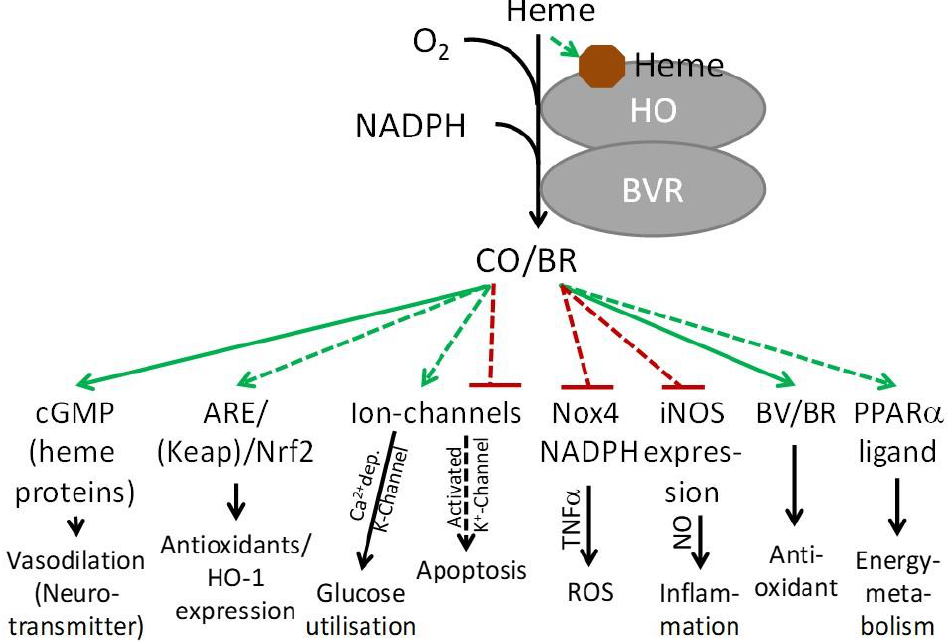
Figure 1. Overview of the predominant mechanisms underlying HO product-mediated cell protection. The two products of HO activity, namely, CO and BV / BR, are associated with the beneficial role of this enzyme. In stimulating cGMP synthesis, CO acts similarly to another gas messenger, NO. It further activates intracellular signaling cascades, involving Nrf2, which provides an anti-oxidative defense, and by interacting with ion channels for modulating glucose metabolism and inhibiting apoptosis. An anti-inflammatory action of BV / BR is predominantly executed by inhibiting generation of reactive oxygen and nitrogen species, via NOX and iNOS. Further, BR / BV possesses potent antioxidant capacity towards oxidation of biomolecules. Recently, BR acts as ligand of PPAR α , thereby controlling lipid and energy homeostasis. Solid arrows indicate the most considered protective pathways. Abbreviations: ARE, antioxidant response elements; cGMP, cyclic guanosine monophosphate; iNOS, inducible NO-synthase; Keap, Kelch-like ECH-associated protein 1; Nrf2, nuclear-factor-E2-related factor-2; NO, nitric oxide; Nox4, NADPH oxidase (isoform 4); ROS, reactive oxygen species. PPAR, peroxisome proliferator activated receptor.